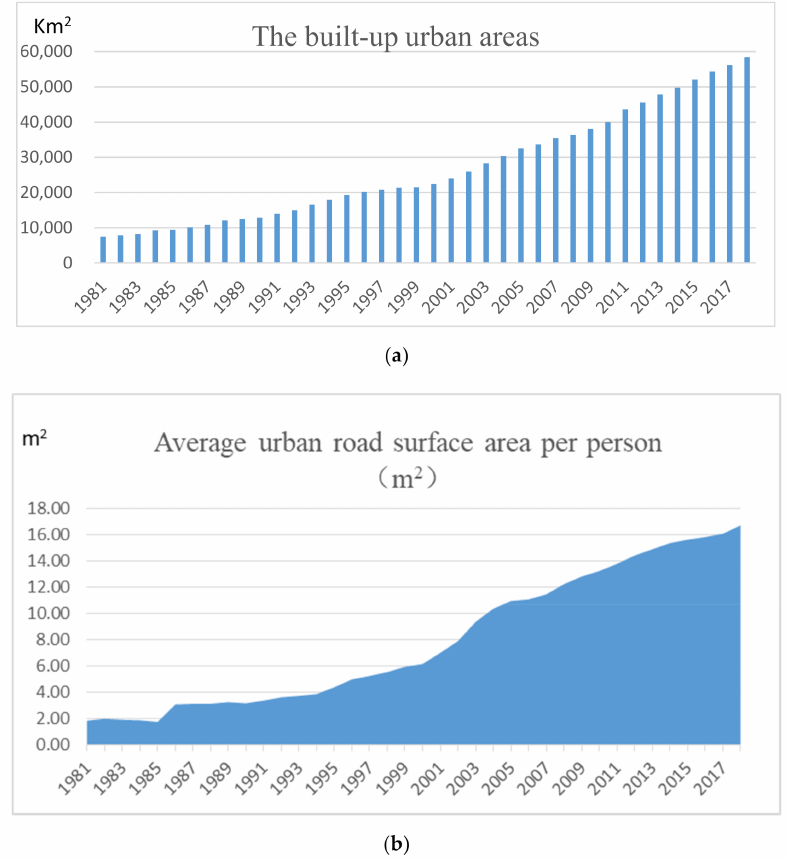
Figure 1. Changes in ( a ) the built-up urban areas from 1981 to 2018 in China and ( b ) the average urban road surface area per person